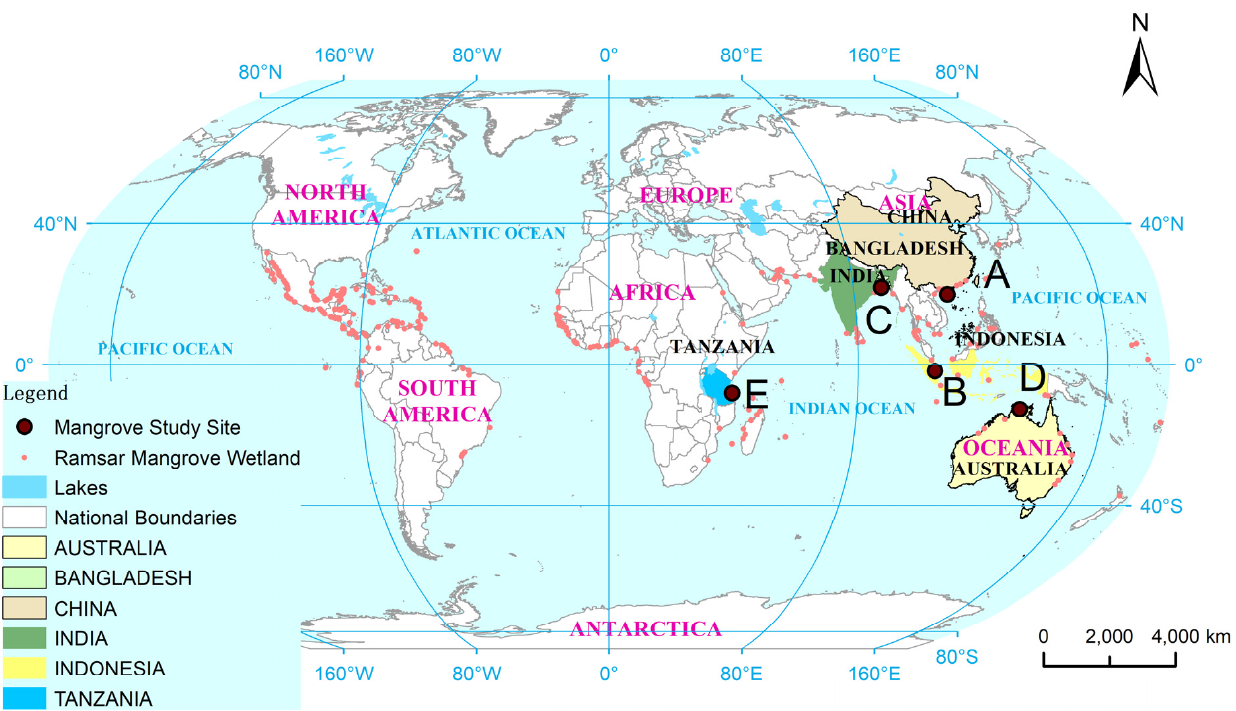
Figure 1. The map of the finally selected sites for the study. (A): Dongzhaigang; (B): Sembilang NP; (C): Sundarban; (D): Kakadu NP; (E):